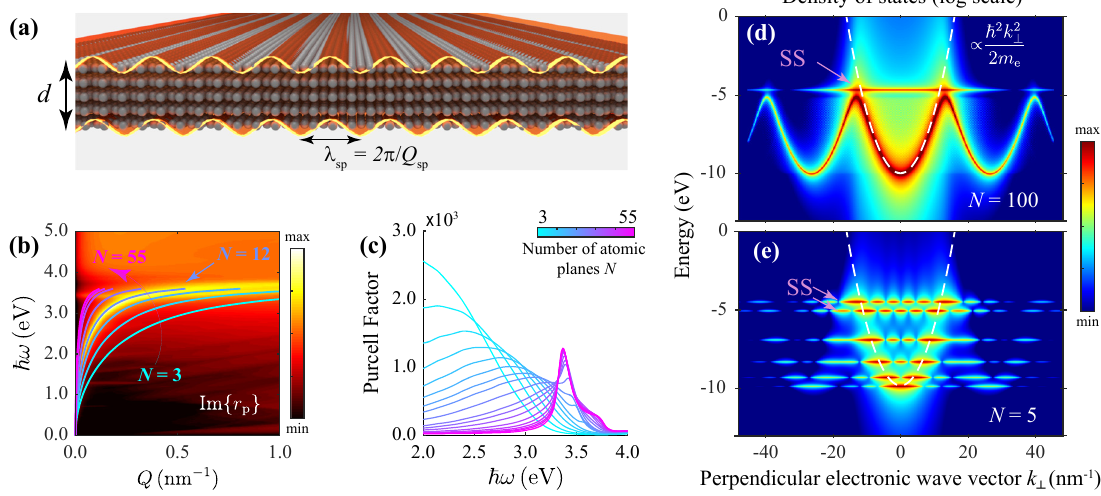
Figure 1: Plasmonic near-field and electronic structure of crystalline thin films. (a) Illustration of an SPP excited in an ultrathin silver film , such that d = Na is the effective film thickness. (b) Contour plot (log scale) comprised of N stacked (111) atomic layers with period a s s } for an Ag(111) film showing the in-plane-wave-vector and photon-energy dependence of the imaginary part of the loss function Im { r p } for films of consisting of N = 12 atomic layers. We superimpose plasmon dispersion curves signaled by maxima in the loss function Im { r p thickness indicated by the color scale in panel (c). (c) Spectral dependence of the Purcell factor for films of thickness indicated by the color ( z ) of occupied scale. (d)–(e) Electronic density of states obtained by Fourier-transforming the out-of-plane electronic wave functions 𝜑 j quantum states to out-of-plane wave-vector space for films consisting of (d) N = 100 and (e) N = 5 Ag(111) atomic layers. A Lorentzian spectral broadening of 21 meV FWHM is introduced. The superimposed dashed white curves indicate the in-plane parabolic dispersion of the first quantum-well state j = 1. Surface states, characteristic of the (111) crystallographic orientation, are highlighted by purple arrows.